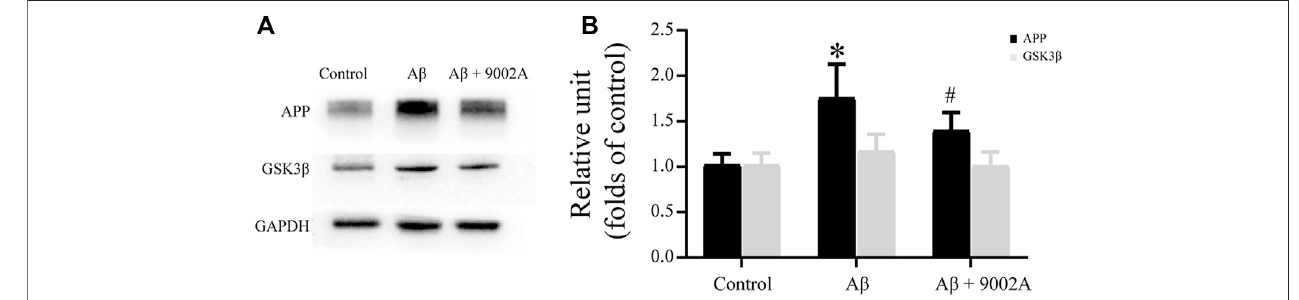
FIGURE 6 | The expression of APP and GSK3 β in the mouse brain of the control group, the A β model group, and the treatment group.